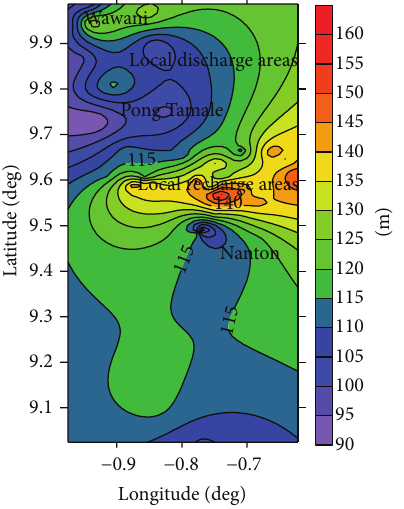
Figure 6: Potentiometric map of the study area showing local recharge and discharge areas.